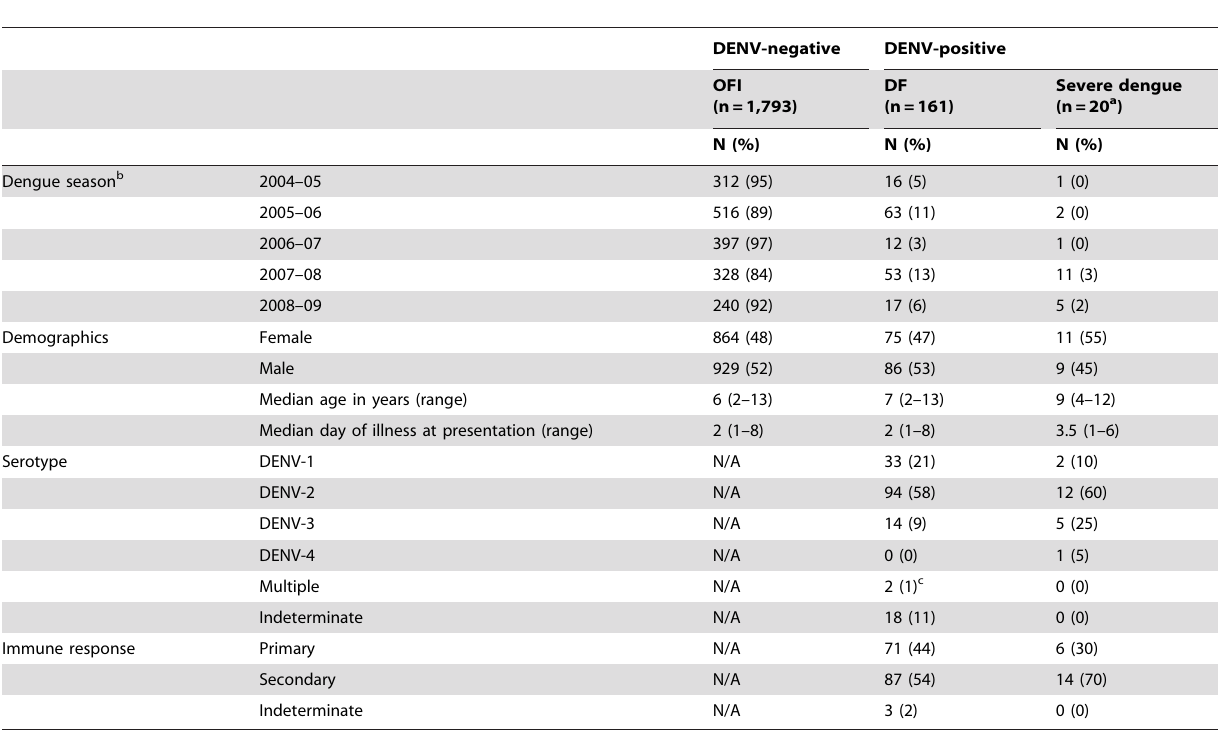
Table 2. Characteristics of study participants by dengue testing results and disease severity (n= 1,974).